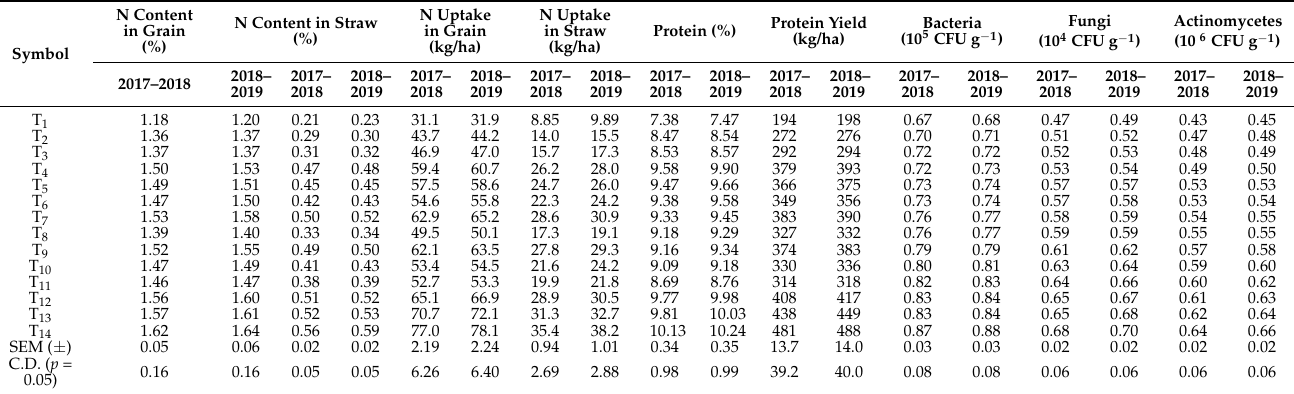
Table 5. Nutrient management strategies impacts on N content (%), uptake (kg/ha) in grain and straw of wheat, and protein content (%) and protein yield (kg/ha) and biological properties of soils.